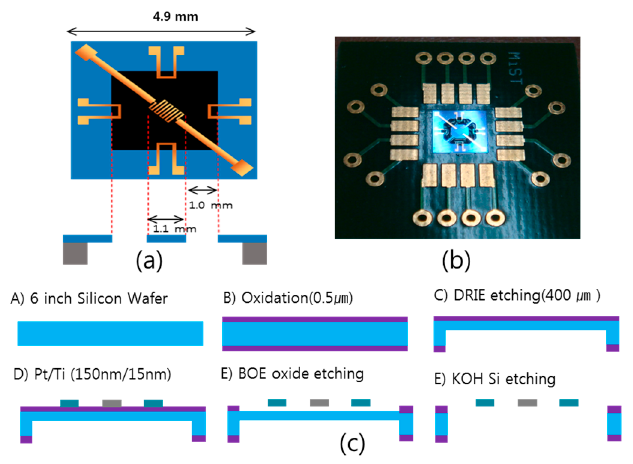
Figure 1. ( a ) Schematic view, ( b ) fabricated sensor on the PCB board and ( c ) fabrication process of the thermal convection–based accelerometer.